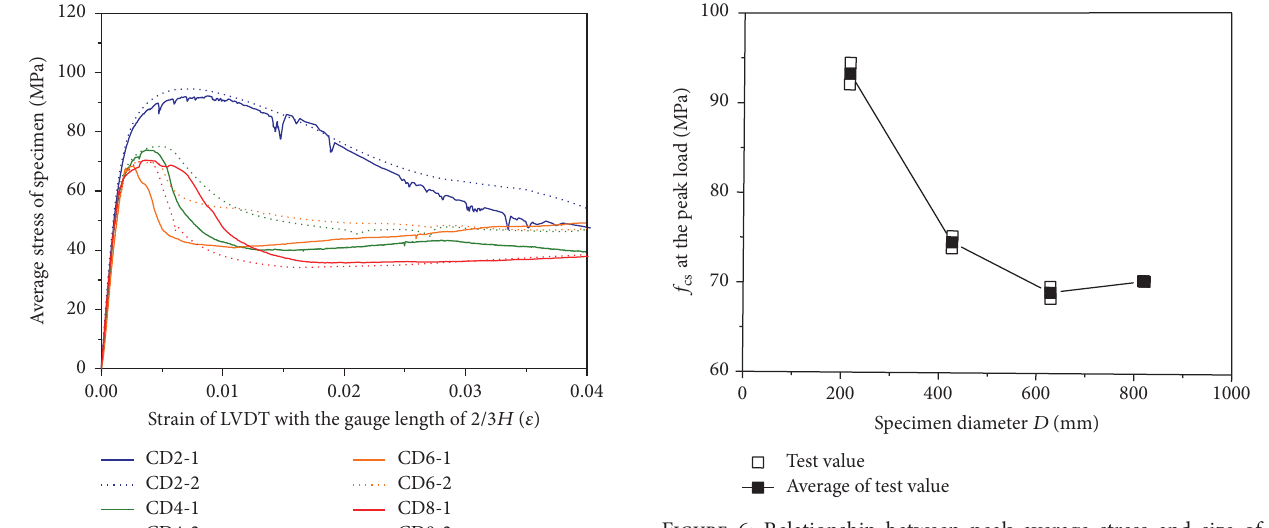
Figure 6: Relationship between peak average stress and size of